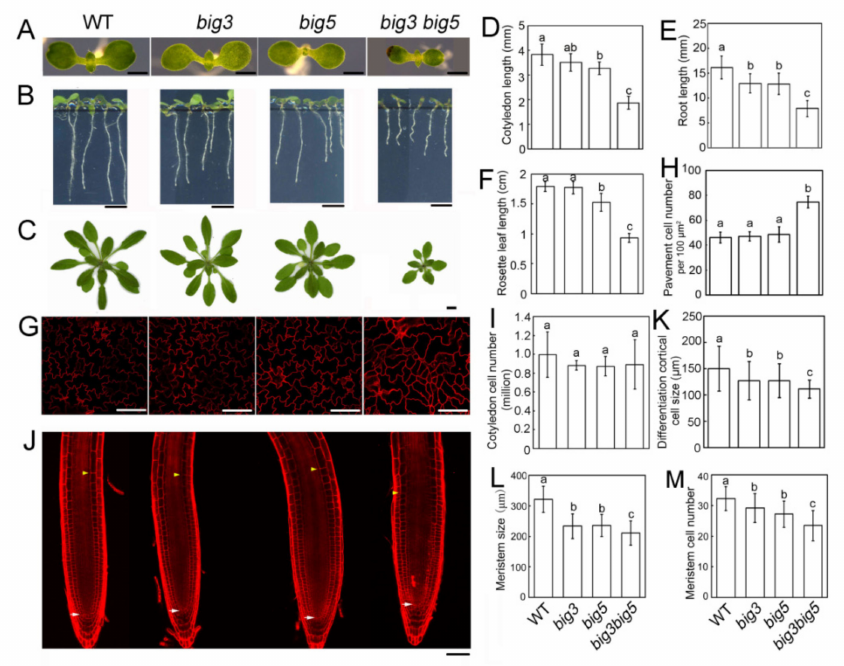
Figure 1. Phenotypic analyses of WT, big3 , big5 and big3 big5 plants. ( A ) cotyledon phenotypes of 7-d-old WT, big3 , big5 and big3 big5 seedlings. Bars = 1 mm. ( B ) root phenotypes of 7-d-old WT, big3 , big5 and big3 big5 seedlings. Bars = 3 mm. ( C ) representative phenotypes of 20-d-old WT, big3 , big5 and big3 big5 plants. Bars = 1 cm. ( D ) quantification of the cotyledon length in ( A ). ( E ) quantification of the root length in ( B ). ( F ) quantification of the third pair of rosette leaf length in ( C ). ( G ) confocal microscopy images of cotyledon pavement cells shown in ( A ). The cotyledons were stained with 10 µ M FM4-64 for 30 min before observation. ( H , I ) quantification of the pavement cell number in ( G ). ( J ) root meristem phenotypes of 7-d-old WT, big3 , big5 and big3 big5 seedlings. The seedlings were stained with 10 µ g/mL PI for 5 min. Bars = 50 µ m. White arrowheads indicate the quiescent center and yellow arrowheads indicate the end of the meristem. ( K – M ) quantification of the differentiation cortical cell size ( K ), the root meristem size ( L ) and meristem cell number ( M ). All the values are presented as mean ± sd ( n > 10), and analyzed with one-way ANOVA and multiple comparisons ( p < 0.05, different letters denote statistically significant